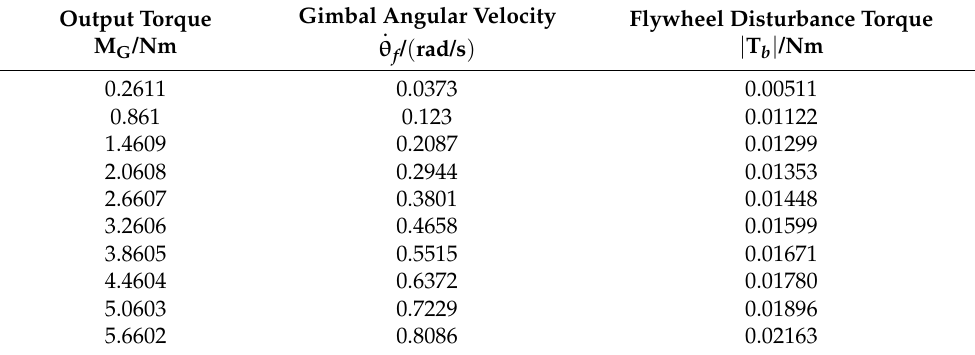
Table 5. Gimbal angular velocity and disturbance torque